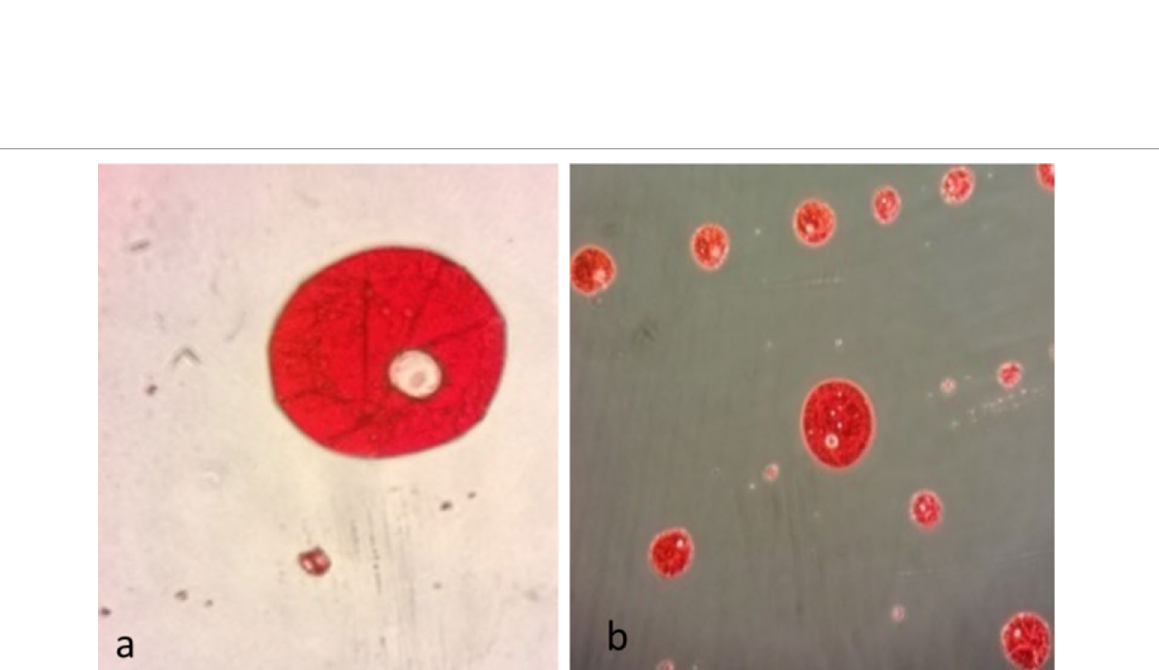
Fig. 11 Stained adipocyte under a 40X magnification and b 10X magnification as observed under inverted microscope Olympus